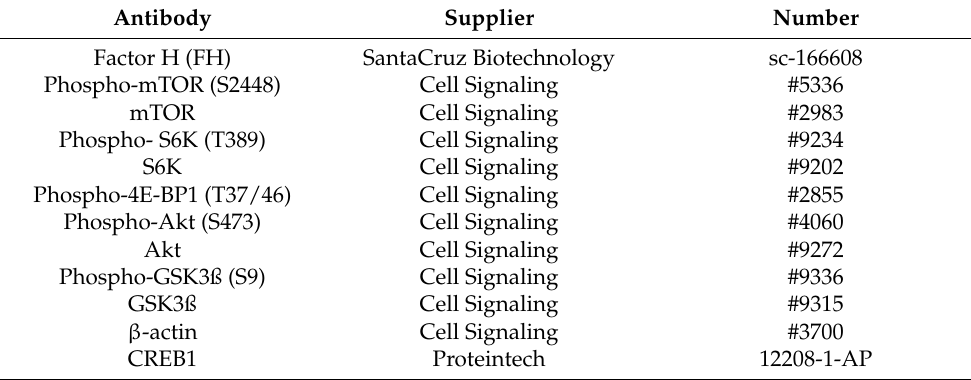
Table 2. Antibody